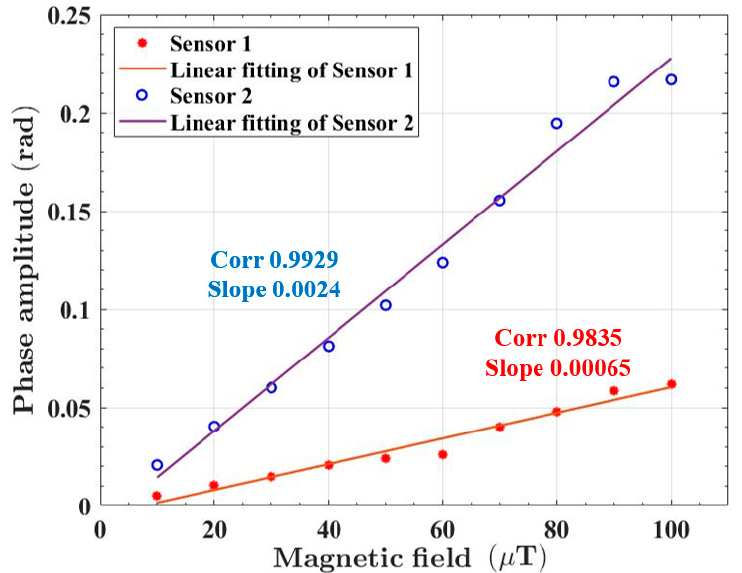
Figure 8. The phase response of optical fiber magnetic field sensors to different magnetic field sig- nals.